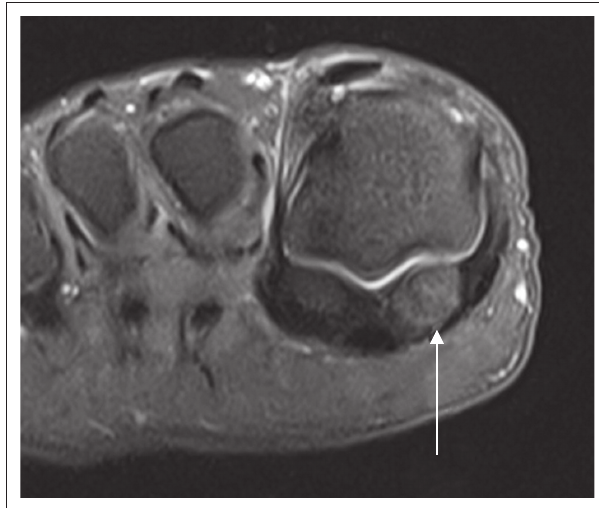
FIGURE 9: Short axis T2 FS MR image of the foot demonstrating oedema in the medial sesamoid (arrow) owing to sesamoid stress changes.